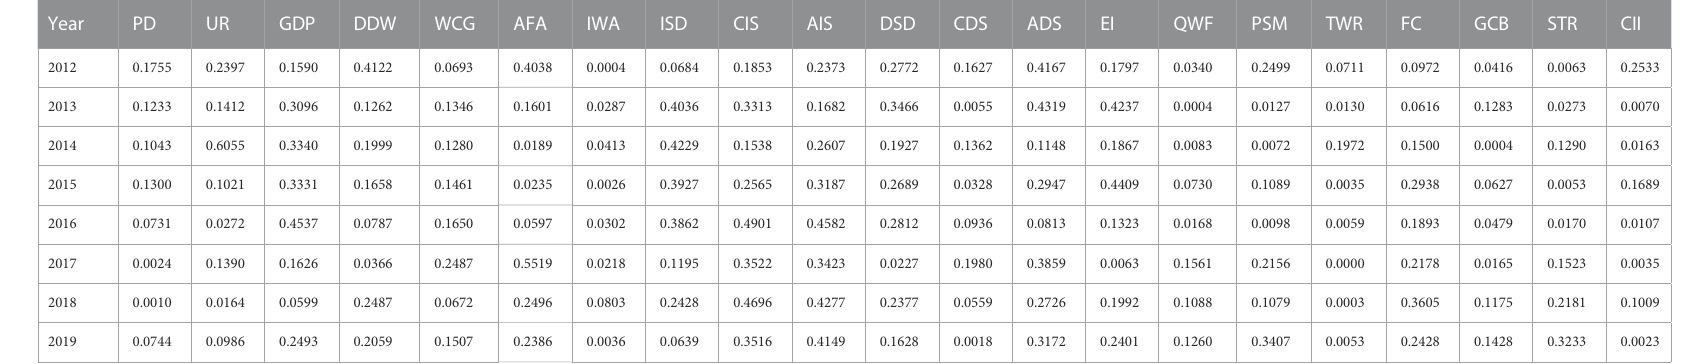
TABLE 8 Optimal projection direction in different years.